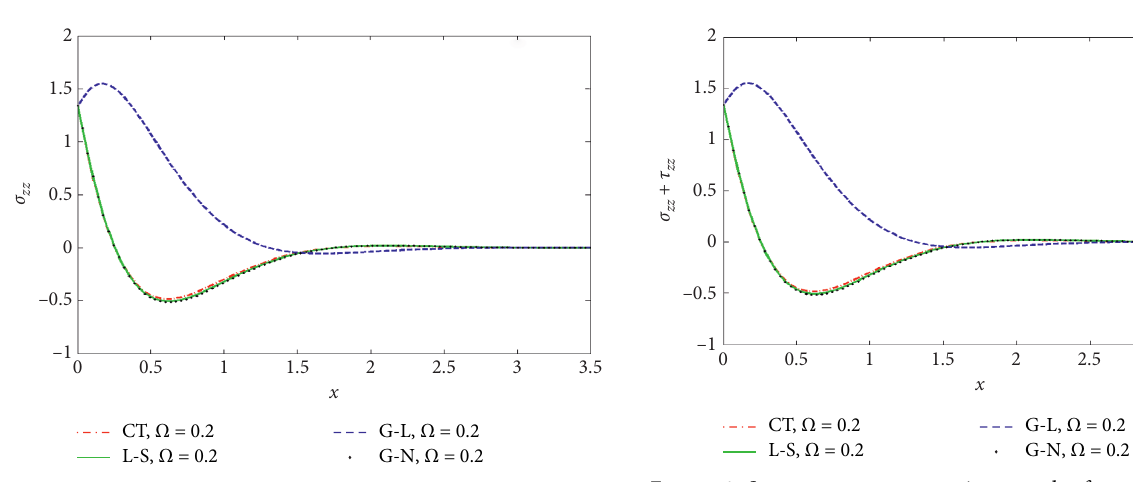
x under four thermoelastic